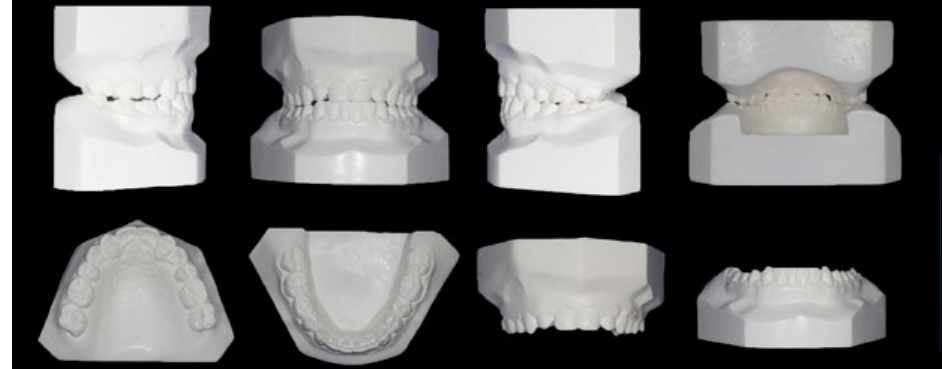
Figure 10. Post-treatment dental